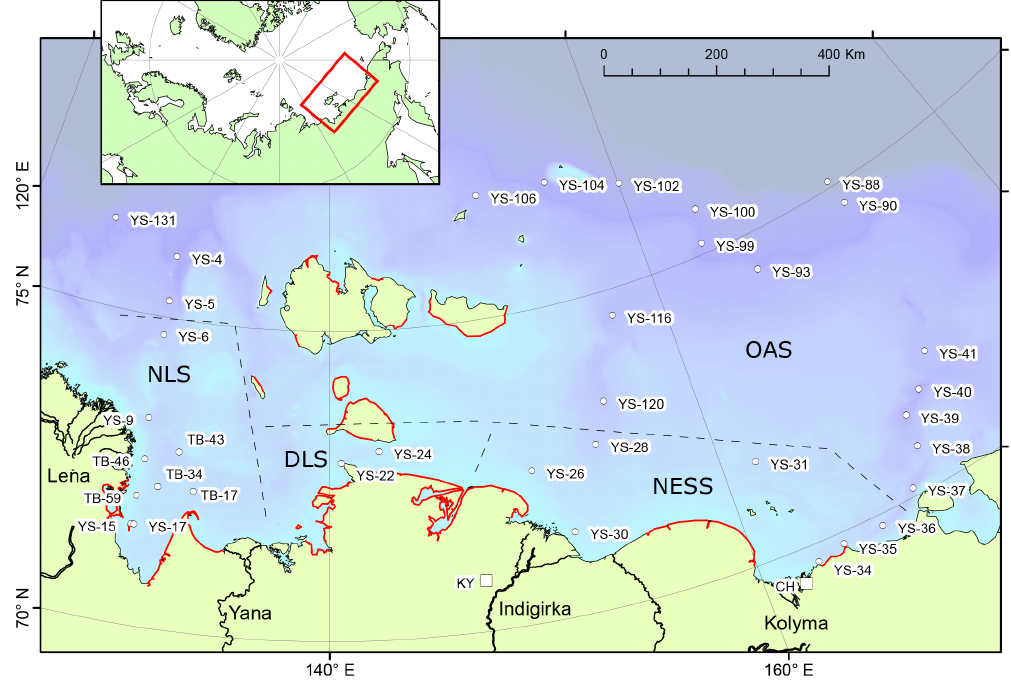
Figure 1. Map of the East Siberian Arctic Shelf (ESAS) showing the location of surface sediment samples (white circles) and ice complex samples (white squares) used in this study. Areas of rapid coastal erosion ( > 1myr − 1 ; Lantuit et al., 2011) are shown in red. Regions of the ESAS referred to in the paper are shown using dashed lines (DLS: Dmitry Laptev Strait; NLS: nearshore Laptev Sea; NESS: nearshore East Siberian Sea; OAS: offshore Arctic